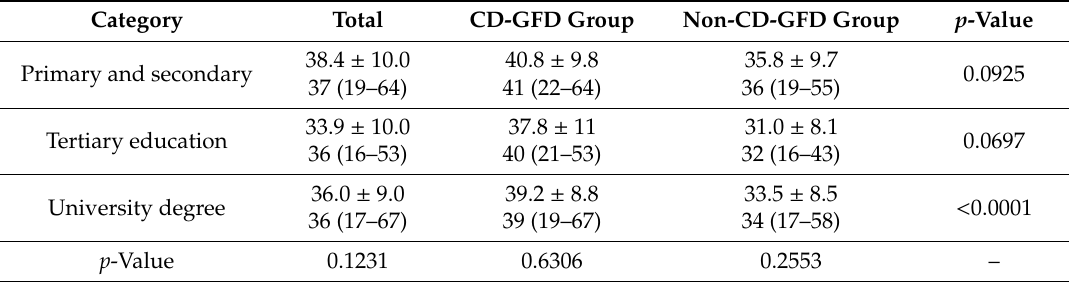
Table 6. Food Neophobia Scale (FNS) scores stratified by educational level in the sub-groups of CD-GFD and non-CD-GFD individuals (mean ± SD and median accompanied by range).